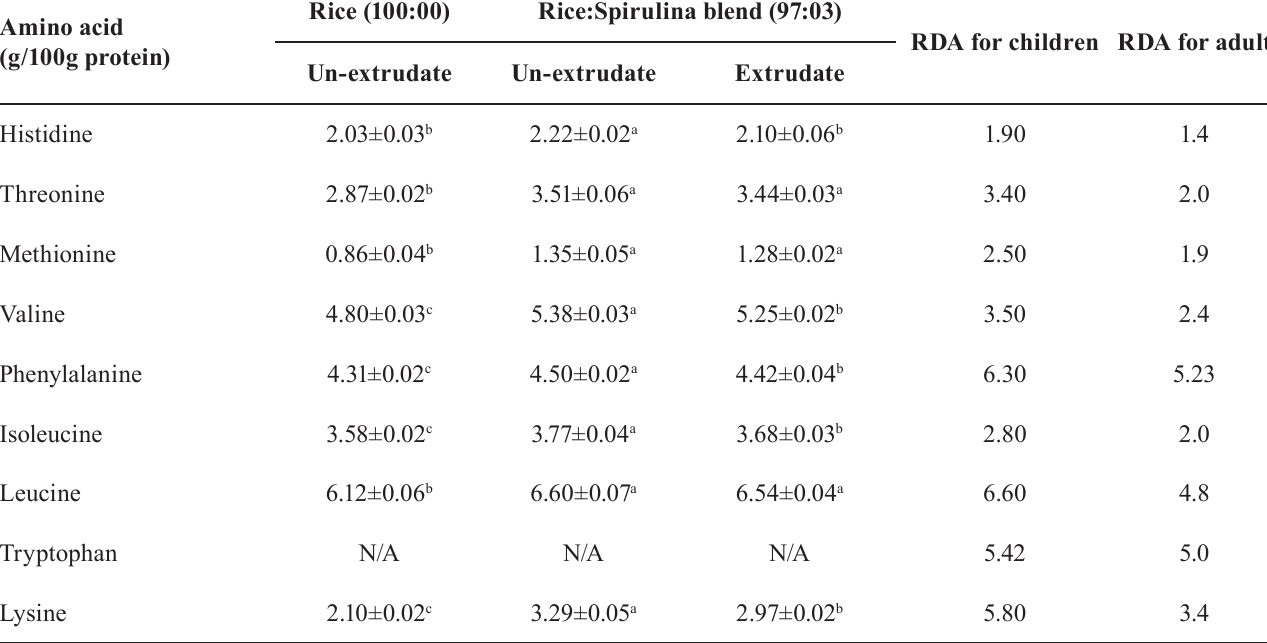
*All values are mean ± SD of three replicates. Mean values with different superscripts on the same column differ significantly (Duncan’s LSD test, P < 0.05). Where, N/A is not analyzed.